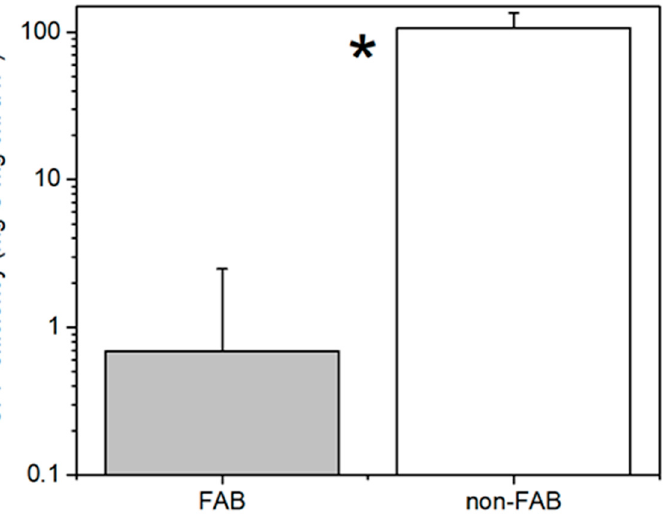
Figure 5. Periphyton gross primary production (GPP) efficiency at FAB (filamentous algae blooms) and non-FAB sites in Bear Lake (June, July, October for FAB, n = 16; just July/October for non-FAB, n = 7. +standard error). * significant difference between FAB and non-FAB values ( t -test, p < 0.05). Although the lake water chl a concentrations were higher in the FAB site (30 ± 7 µ g L − 1 , n = 5) compared to the non-FAB site (7 ± 10 µ g L − 1 , n = 3), the re- sulting planktonic GPP rates in both sites were minor compared to the overall measured rates (FAB mean = 25 ± 7 mg C m − 3 h − 1 ; non-FAB mean = 4 ± 10 mg C m − 3 h − 1 ). All measurements are means ± standard